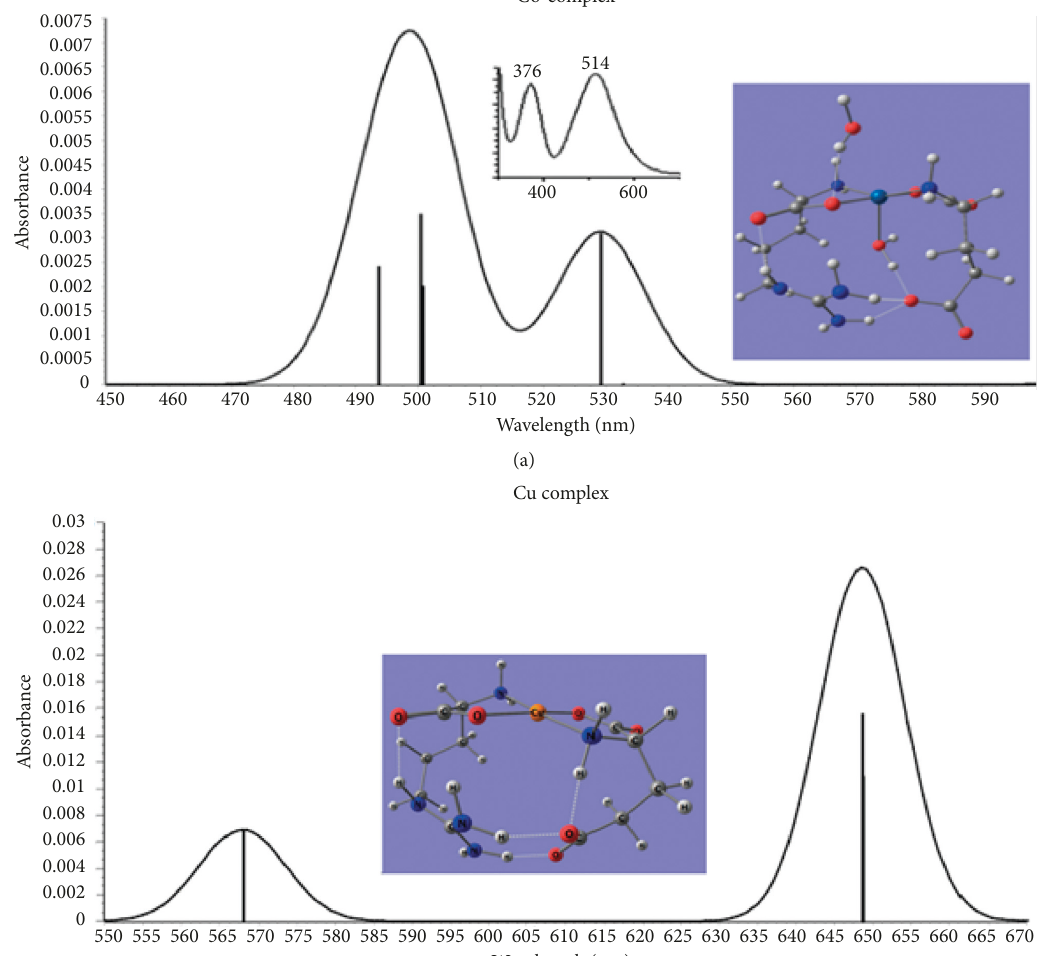
Figure 4: Theoretical and experimental (inset) UV-Vis spectra of aqueous Co and Cu complexes reflecting the excellent agreement between the results.